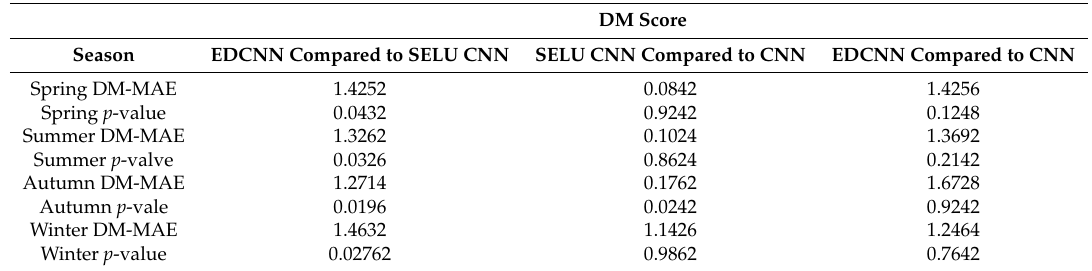
Table 4. Diebold–Mariano test results at a 95% confidence level and 5% significance level of p -value.